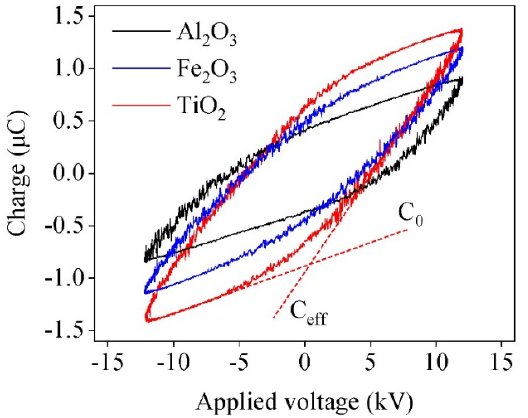
Figure 3. The Lissajous figures of the reactor filled with Al 2 O 3 , Fe 2 O 3 , and TiO 2 . (Driving frequency: 12.6 kHz; peak applied voltage: 24 kV; total gas flow rate: 500 mL/min; discharge gap: 3 mm).